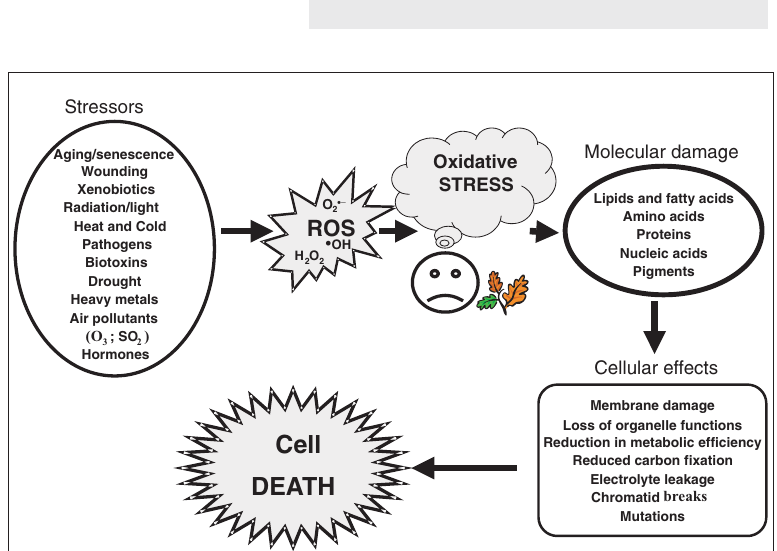
Figure 5. Oxidative stress results from imbalance between the lev- els of antioxidants (AOX) and re- active oxygen species (ROS). Cells are normally able to bal- ance the production of oxidants and antioxidants to maintain re- dox equilibrium. Oxidative stress occurs when this equilibrium is upset by excess levels of ROS, or depletion of antioxidant de- fenses.